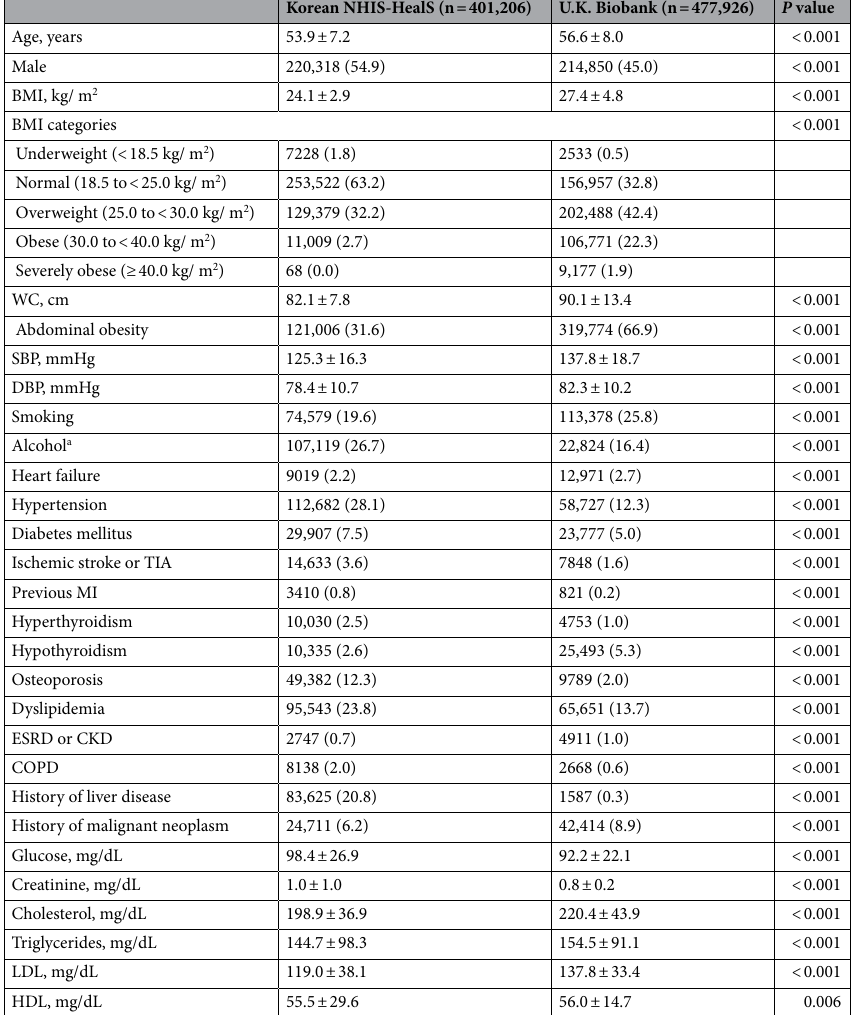
disease, DBP diastolic blood pressure, ESRD end-stage renal disease, HDL high-density lipoprotein, LDL low-density lipoprotein, MI myocardial infarction, NHIS-HealS National Health Insurance Service’s Health Screening, SBP systolic blood pressure, TIA transient ischemic attack, WC waist circumference. a Alcohol